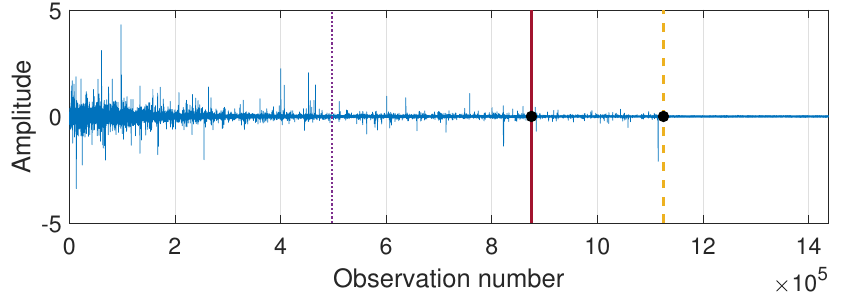
Figure 14. Simulated signal with regime change points marked in purple (dotted line), red (solid line), and yellow (dashed line) and the theoretical moments of σ and α stabilization marked with black